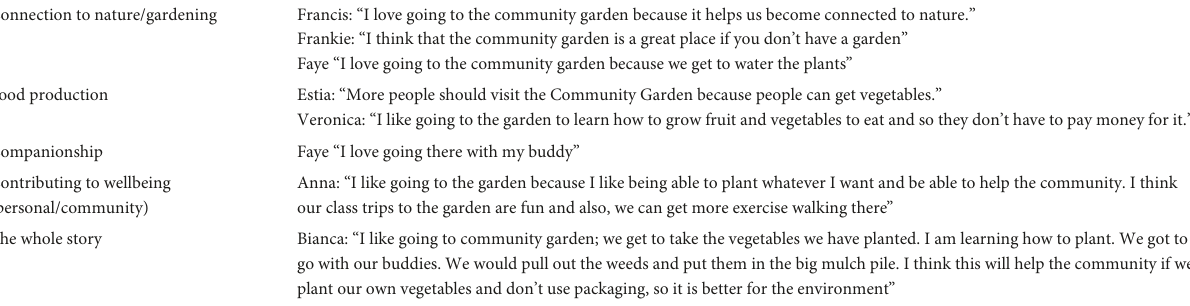
TABLE 1 Students’ comments on the value of the garden. Connection to